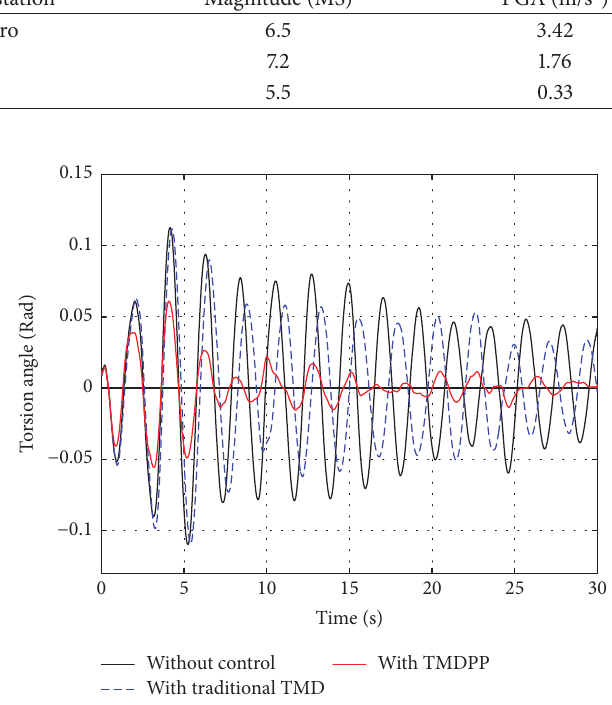
Figure 9: Damping comparison of structural displacement in 𝑦 direction.